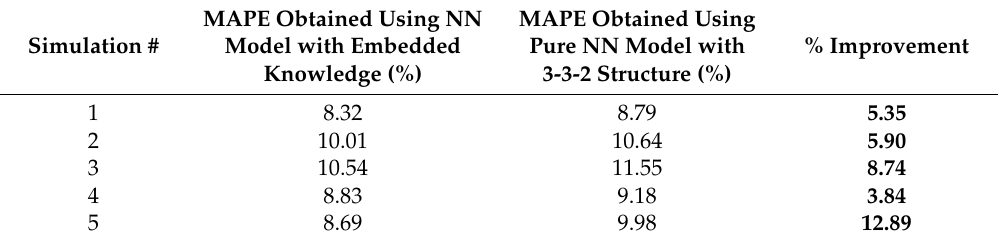
Table 4. Comparison of the MAPE obtained for the test set using the pure NN model with a 3-4-2 structure and the NN model with embedded